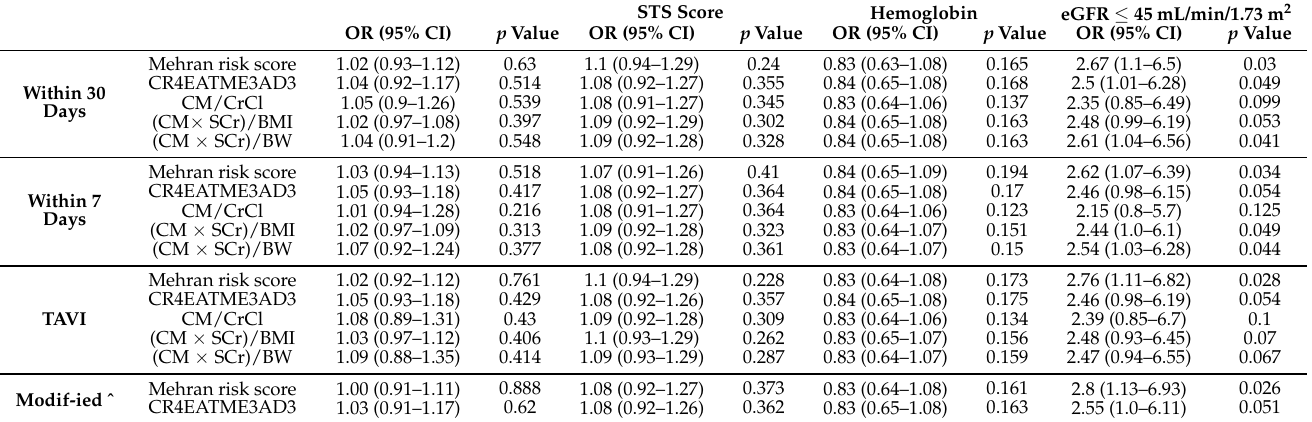
Table 5. Multivariable logistic regression analyses for the prediction of post-TAVI